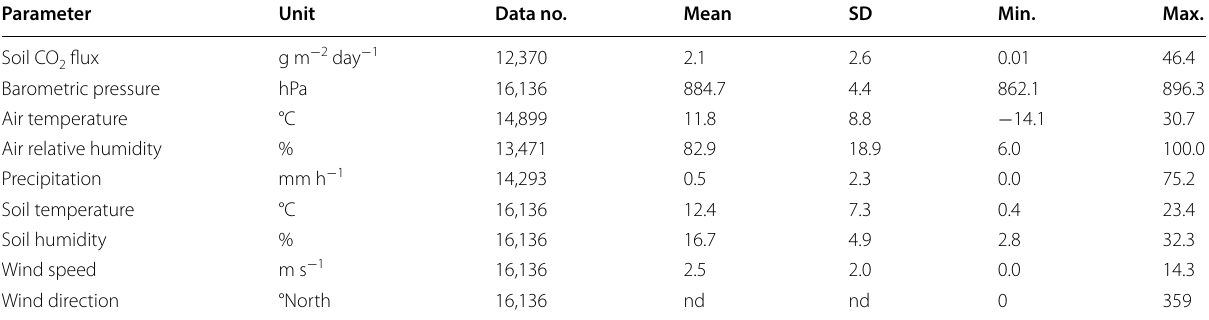
SD Standard deviation, nd not determined